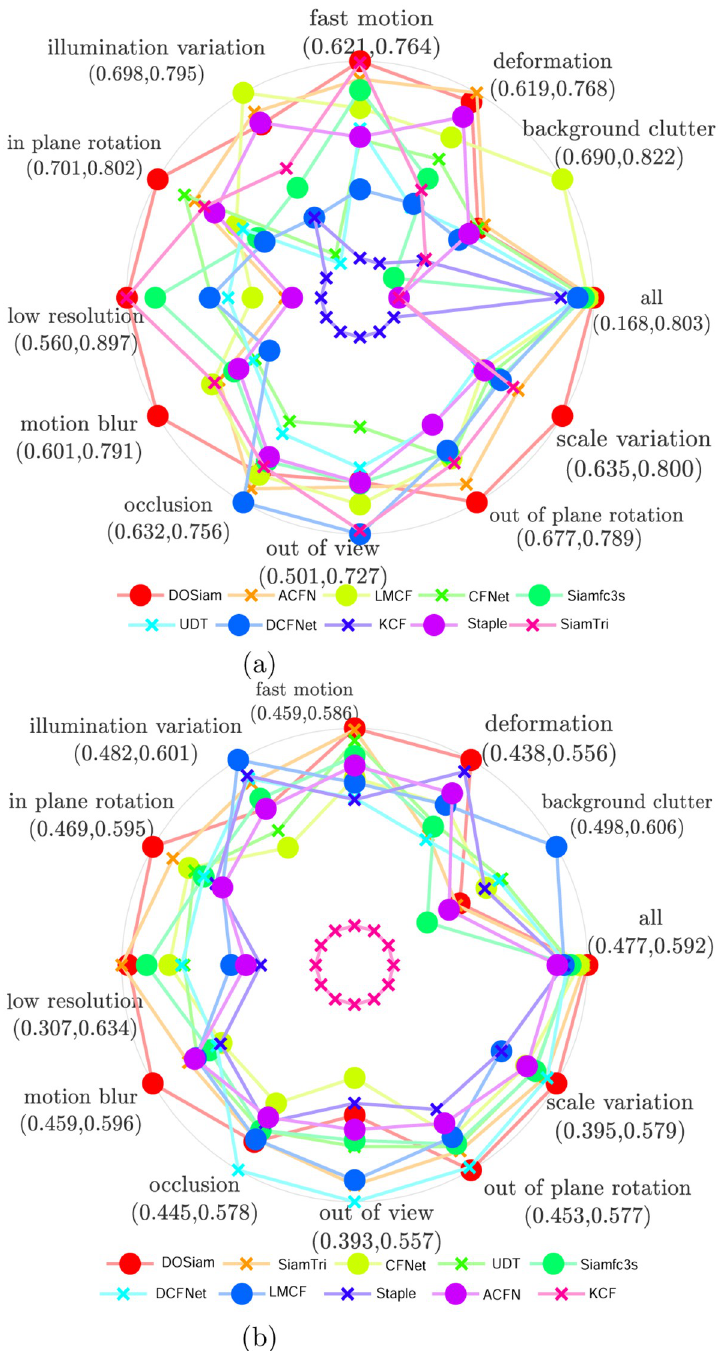
Fig 7. A comparison of the DOSiam with state-of-the-art trackers in terms of success rate and precision on OTB2015 with different attributes.